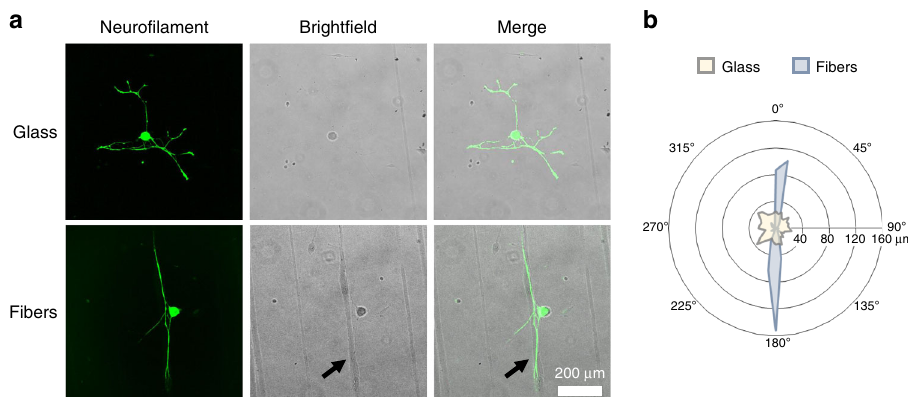
Fig. 7 Electrospun P1 fi ber contact guidance for dissociated cortical neurons. a Dissociated cortical neurons cultured onto P1 fi bers electrospun onto glass cover slips extended neurites without directional preference when neurons attached to glass surface in the absence of fi bers. However, when neurons attached to scaffolds near P1 fi bers (as seen in the Bright fi eld image pane), neurite extension from the neurons followed fi ber orientation. b Polar histograms representing mean neuron morphology demonstrate the contact guidance cues provided by P1 fi bers. ( n = 18 neurons on glass, and 16 neurons on P1 fi bers, scale bar is 200 µ m)